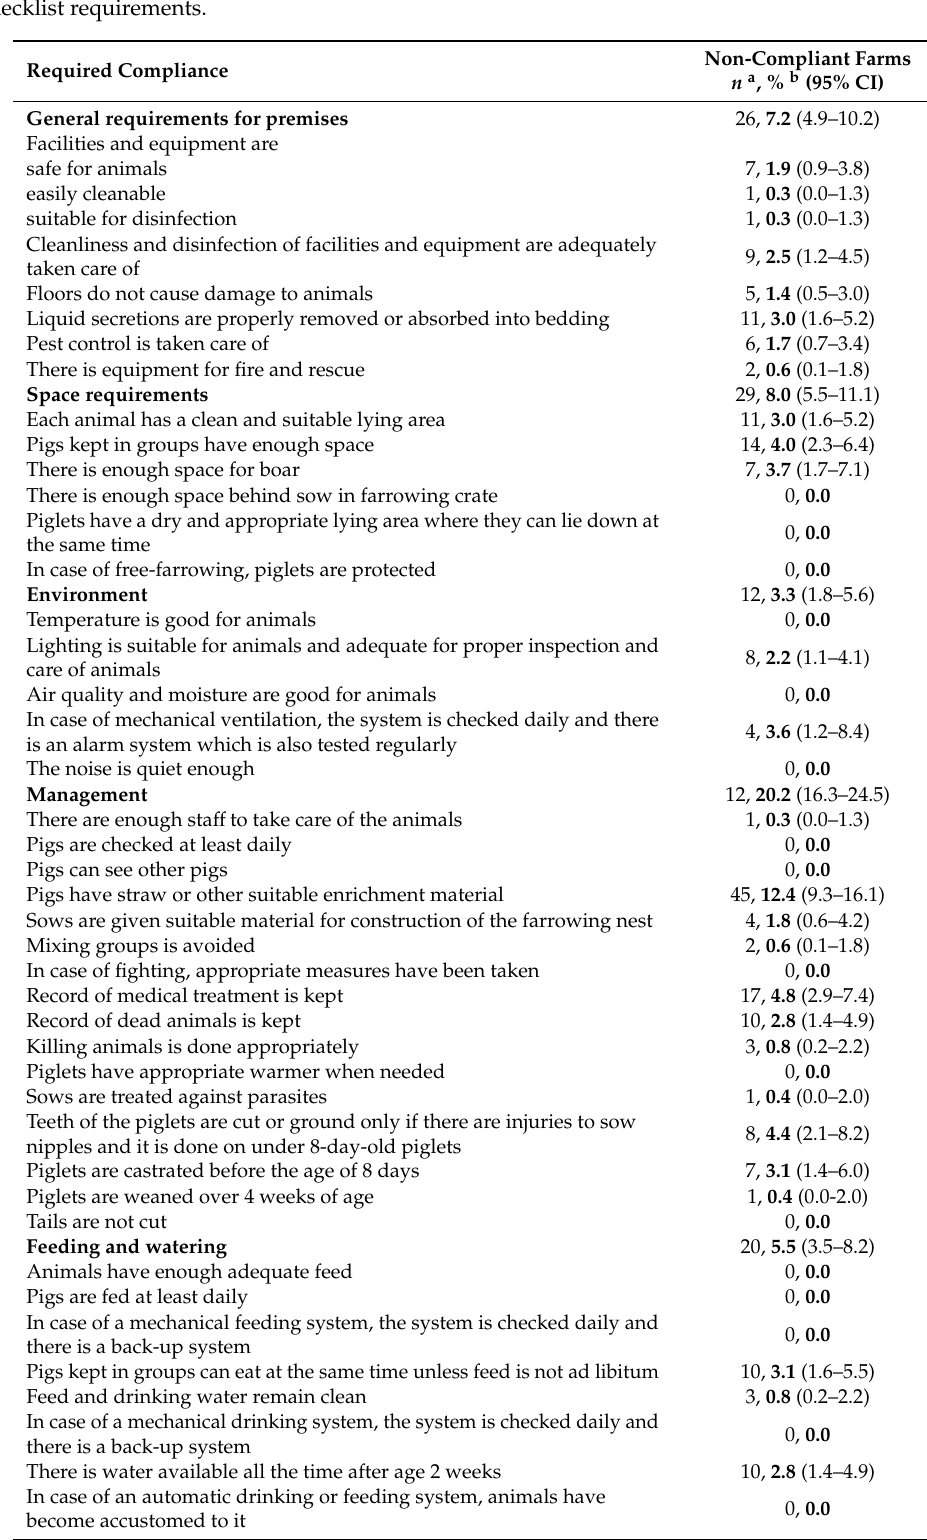
Prevalence of pig farms not complying with the main welfare categories or the checklist